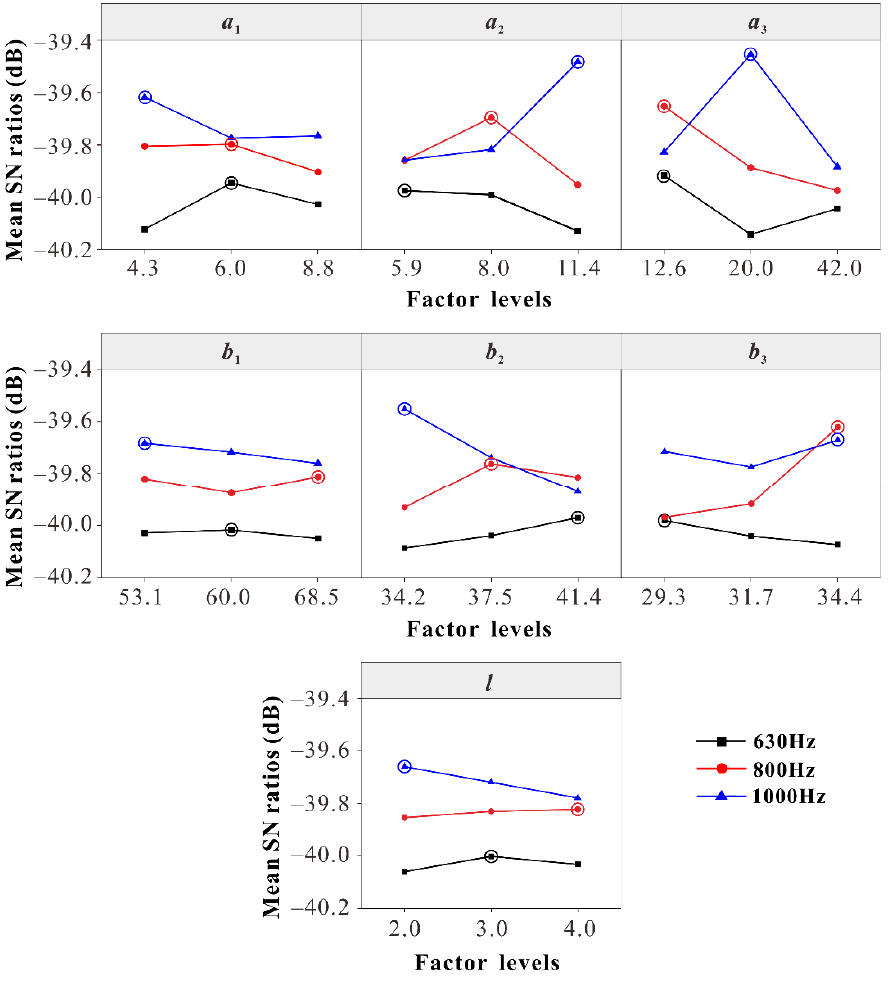
Figure 7. Response plots of the mean SN ratios for the frequencies of 630 Hz, 800 Hz and 1000